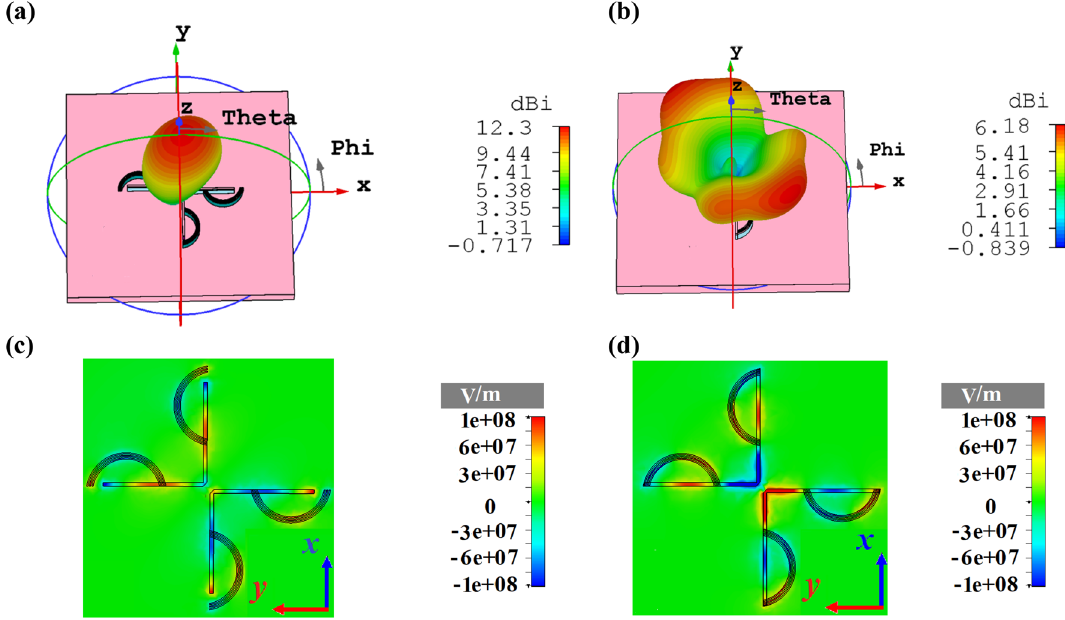
Figure 6. 3D radiation patterns of cross dipole nano-antenna with three circular sectors at 1550 nm for ( a ) l d = 517 nm, ( b ) l d = 617 nm. The z-component of electric field distributions at 1550 nm for ( c ) l d = 517 nm and ( d ) l d = 617